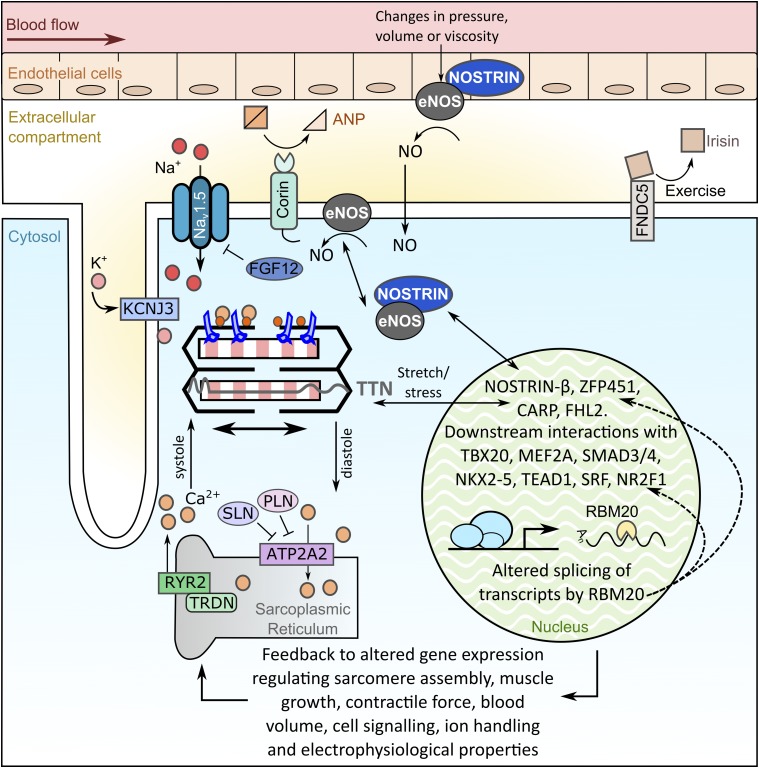
A model for pulmonary myocardium gene regulation in response to hemodynamic stress. Based on our gene network analysis we propose that hemodynamic changes trigger mechanosensory (stretch-stress) signaling from the sarcomere via TTN, and initiate NO signaling cascades which are transmitted to the myocyte nucleus via NOSTRIN. These signals initiate dynamic regulation of gene expression to enable fine-tuning of the contractile properties of the pulmonary myocardium. Gene expression changes may also be regulated at the post-transcriptional level by RBM20 which could feedback to regulate Nostrin, Ttn, and Zfp451. Collectively, these effects are predicted to result in altered contractile properties, ion handling, and hormonal signaling in the pulmonary myocardium to direct an effective response to the initial hemodynamic cue.